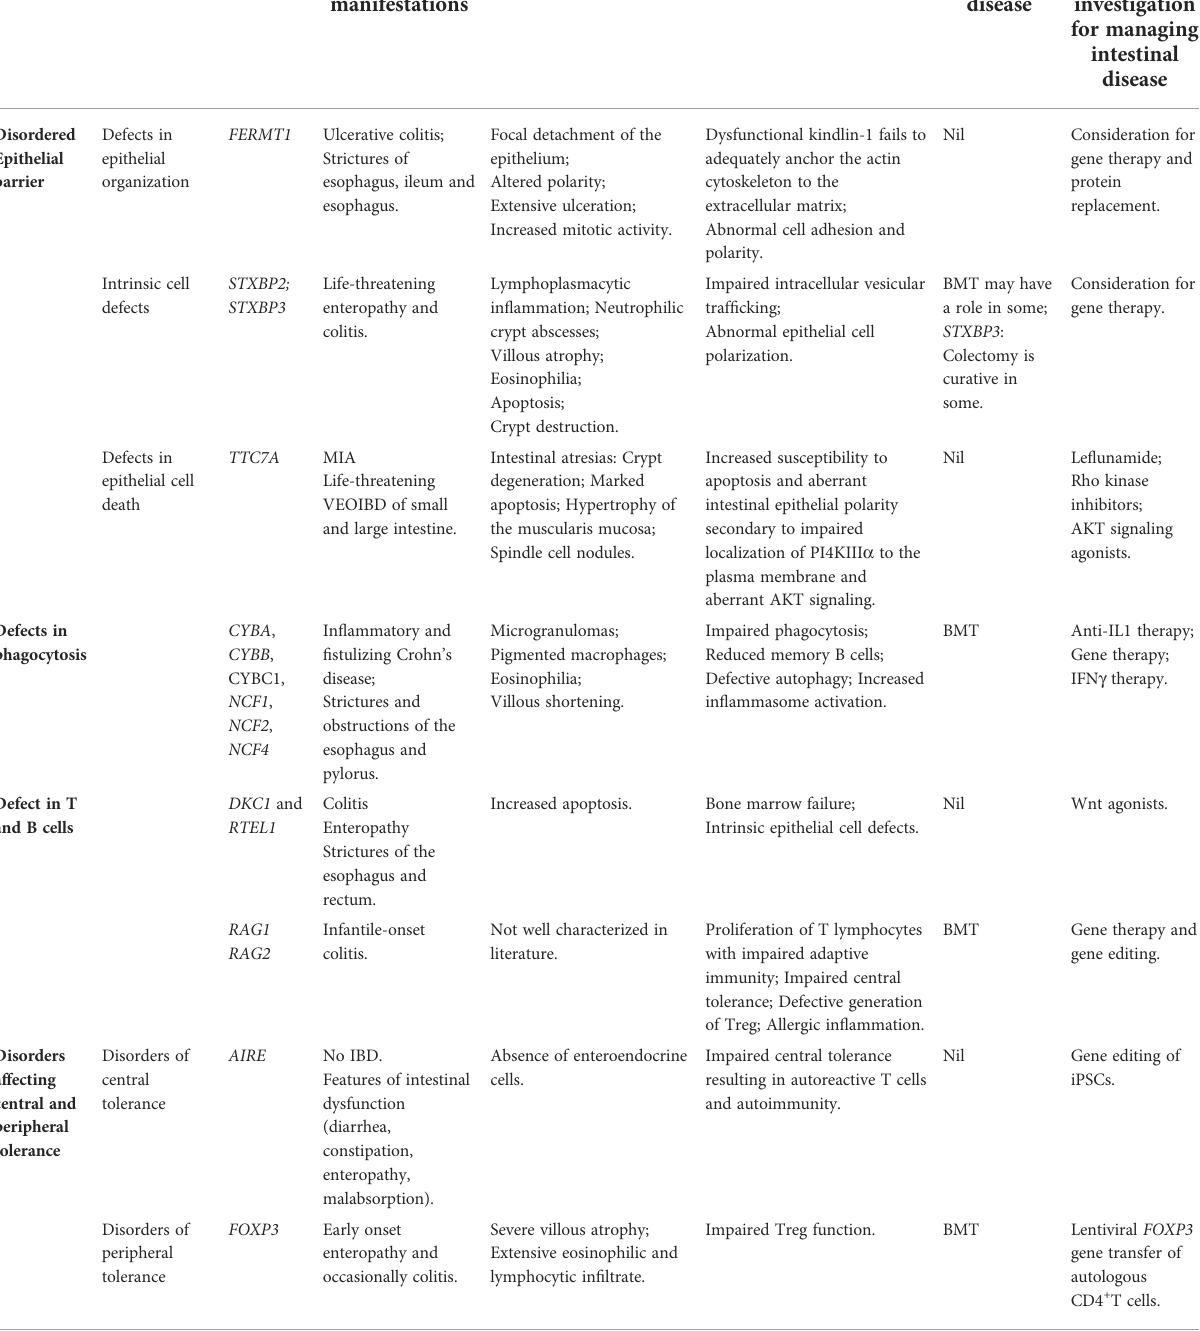
TABLE 2 Selection of IEI resulting in IBD, histologic features and molecular mechanisms of intestinal disease and summary of available cures and therapeutics warranting further